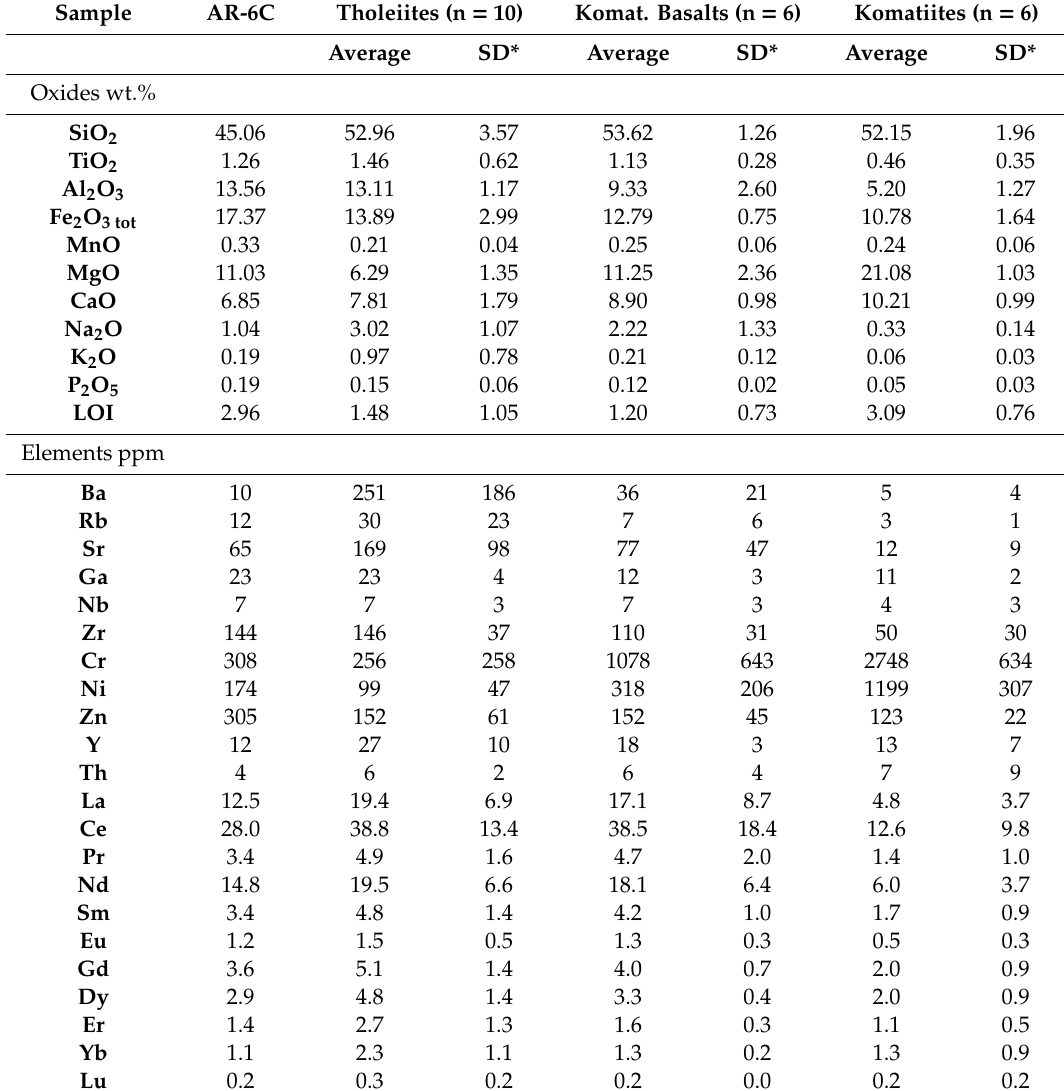
Table 1. Major and trace element averages for AR-6C sample and tholeiites, komatiitic basalts and komatiites from Aravalli area.